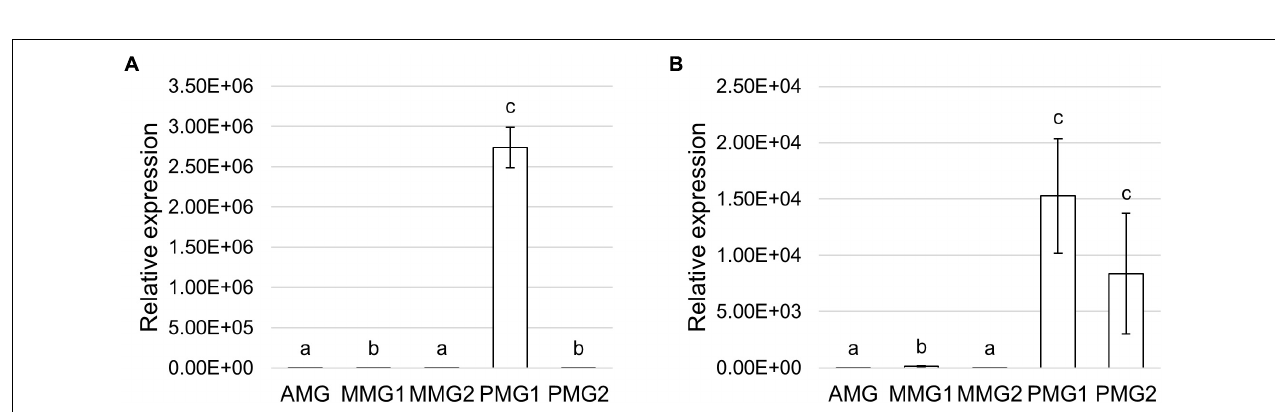
FIGURE 8 | Total proteolytic activity in the different midgut regions. (A) Total proteolytic activity in midgut juice extracted from anterior, middle, and posterior midgut. For each tract the enzymatic assay was performed at a pH value as close as possible to that of the lumen (pH 6.0 for the AMG, pH 5.0 for the middle midgut, and pH 8.5 for posterior midgut). The values are reported as mean ± SEM of at least 3 experiments. Different letters denote significant differences (ANOVA test followed by Tukey’s test. ANOVA p -value < 0.001, Tukey’s test p -values: Middle vs. Anterior p = 0.975, Posterior vs. Anterior p < 0.001, Posterior vs. Middle p < 0.001). (B) Dependence of total proteolytic activity on temperature in midgut juice from the posterior region of the midgut performed at pH 8.5. Relative activity values (%) are reported as mean ± SEM of at least 3 experiments and are expressed as percentage of the highest activity over the temperature range examined. (C) Total proteolytic activity in midgut juice from the posterior midgut measured at pH 8.5 and 5.0. The values are reported as mean ± SEM of 3 experiments. Different letters denote significant differences (paired t -test: p -value < 0.05). (D) Total proteolytic activity in midgut juice from the posterior midgut measured at pH 8.5 in the absence (control) and in the presence of serine- (PMSF) and cysteine- (E-64) protease inhibitors. The values are reported as mean ± SEM of 5 experiments. A significant difference between groups was observed for the activity measured in the presence of PMSF vs. control (paired t -test: ∗ p -value < 0.01).